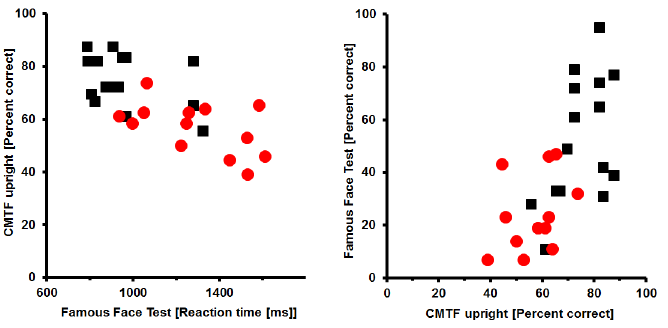
Fig 5. Scatter plot relating performance in two tests of face processing (CMTF versus FFHRT). Performance of persons with cPA is illustrated by filled red circles; performance by unimpaired controls is illustrated by filled black